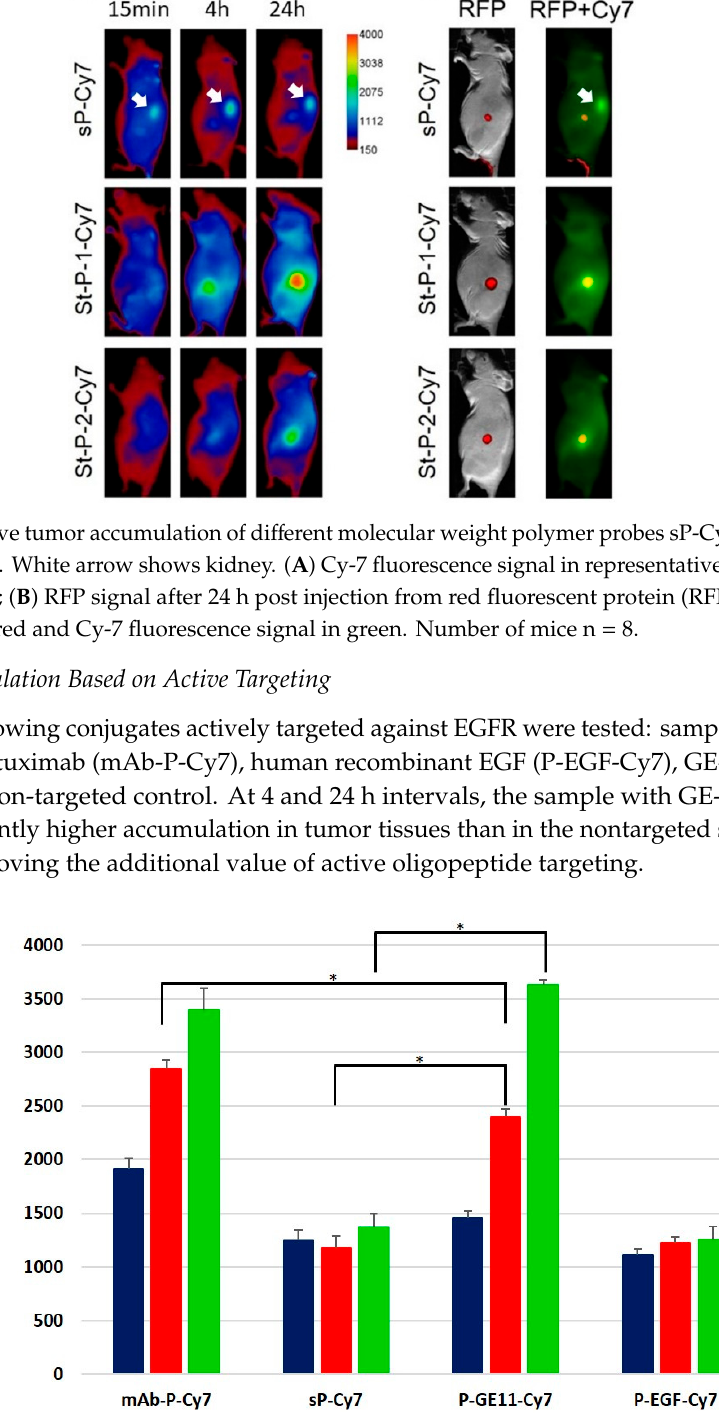
Figure 4. In vivo tumor accumulation of different molecular weight polymer probes ( sP-Cy7, St-P-1- Cy7 and St-P-2-Cy7) with the same percent (2.4%) weight of Cy-7 fluorescent dye. MFI was determined by the In-Vivo Xtreme In Vivo Imaging System. The data are presented as the mean ± SEM of duplicates from two independent experiments. * P values < 0.001. Number of mice n = 8.